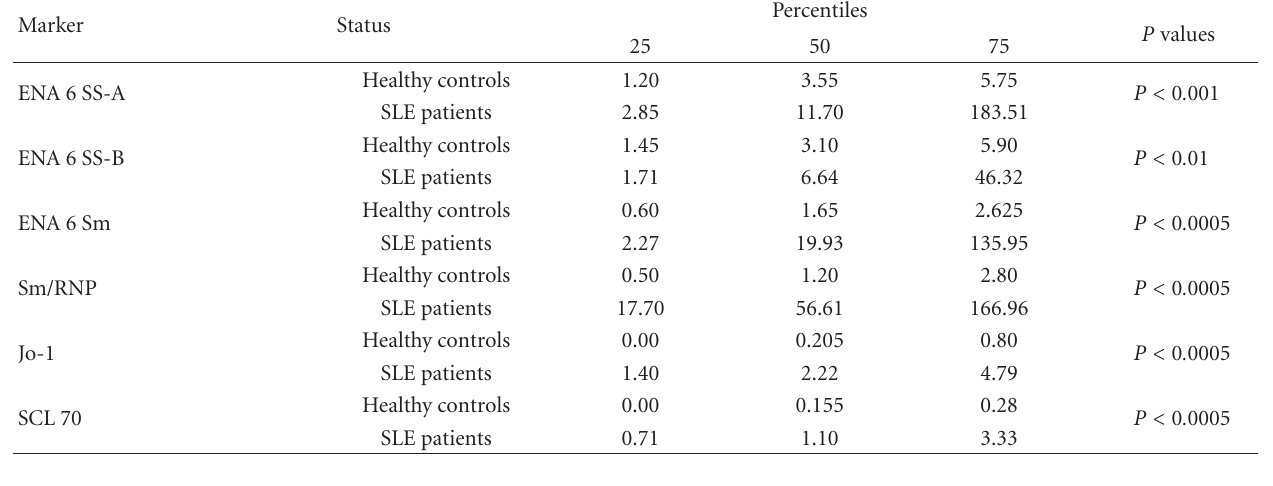
Table 3: The median and interquartile range of serum concentration of ENA6 profile in the healthy subjects and in the SLE patients. Marker